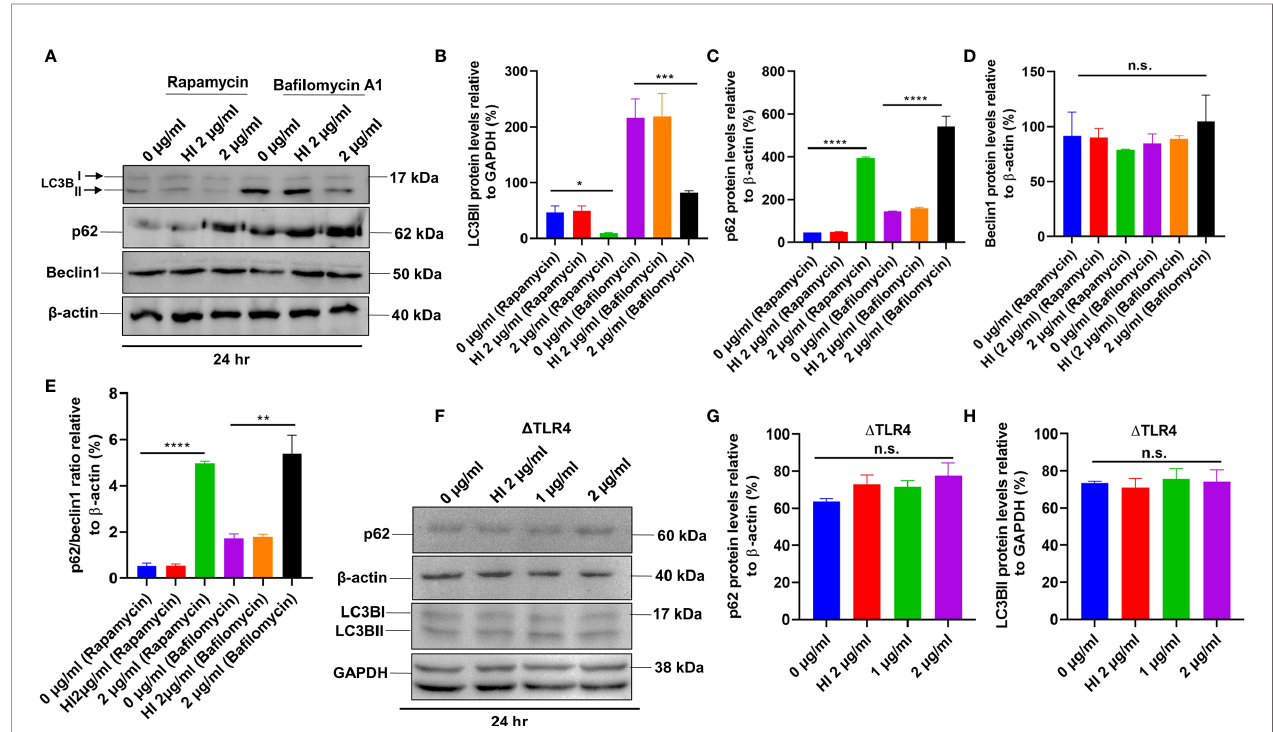
FIGURE 8 | PE6 inhibits autophagy initiation of RAW264.7 cells in the presence of rapamycin and ba fi lomycin A1. (A) Western blot showing the levels of autophagy markers LC3BII, p62, and Beclin1 in RAW264.7 cells treated with PE6 in the presence of rapamycin (200 nM) and ba fi lomycin A1 (50 nM). Untreated and HI PE6 treated cells were used as negative controls. b -actin and GAPDH were used as loading controls. (B – E) Densitometric quanti fi cations of LC3BII, p62, and Beclin1 bands are shown relative to b -actin and GAPDH [%]. p62/Beclin1 ratio is shown as a bar graph. (F) Western blot demonstrating the levels of p62 and LC3BII in D TLR4 mouse macrophage cells. b -actin and GAPDH were used as loading controls. Untreated and HI PE6 treated cells were used as negative controls. (F – H) Densitometric analysis of p62 and LC3BII bands relative to b -actin. Data were analyzed by one-way ANOVA with Tukey ’ s multiple comparison post-test. Data are representative of two independent experiments. *P < 0.05, **P < 0.01, ***P < 0.001, ****P < 0.001 vs . controls. n.s; difference not signi fi